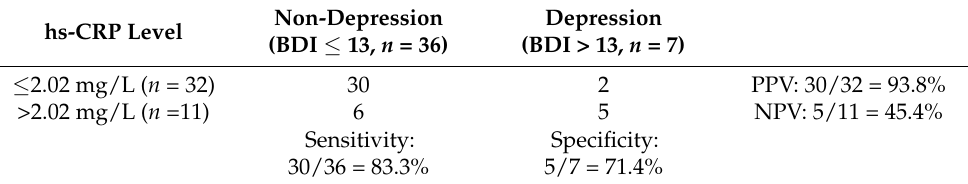
Table 4. Logistic regression analysis of postoperative depression status and other potentially associated factors.